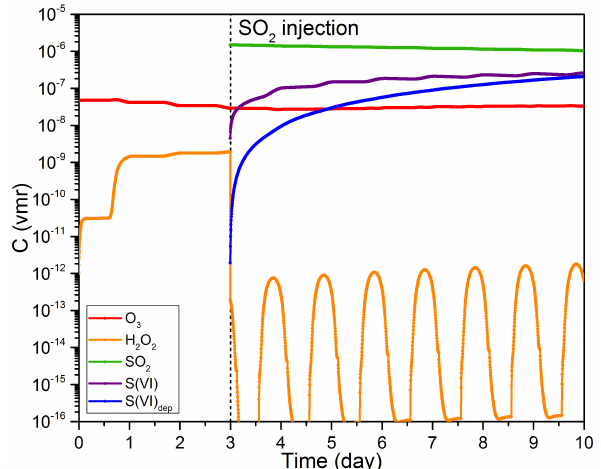
Figure 7. Time evolution in the gas-phase concentrations of SO 2 , its tropospheric oxidants and produced and deposited sulfates dur- ing S3. During the S3 simulation the concentration of injected SO 2 drops from 1.5ppmv to a final value of 1ppmv.